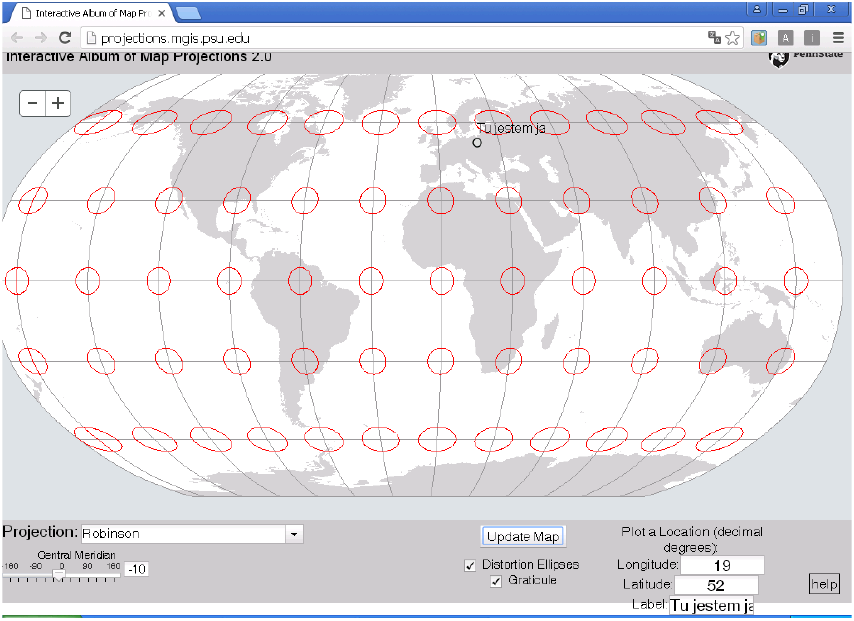
Fig. 12. The Interactive atlas of cartographical projections (source: